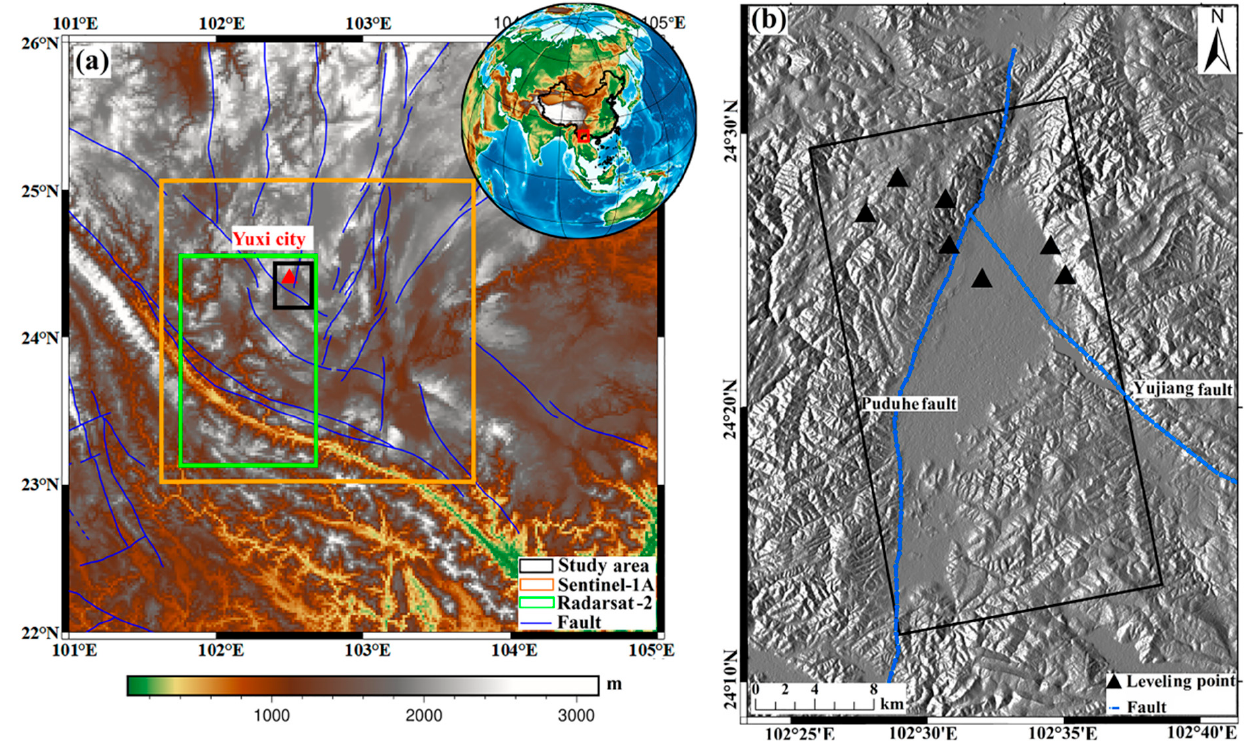
Figure 2. ( a ) Topography map of the Yuxi Basin study area. The red box and solid black line in the upper right corner represent the study area, which is delineated in detail with topographic data in ( a ). ( b ) Outline of Yuxi city in ( a ) in the red triangular area; the background map is the topographic map from the SAR simulation. The black rectangular border is the scope of the test area.